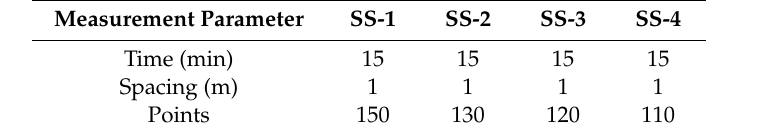
Figure 5. Schematic diagram of temperature monitoring using thermal line sensor system. Table 5. Measurement settings for temperature monitoring using thermal line sensor system.